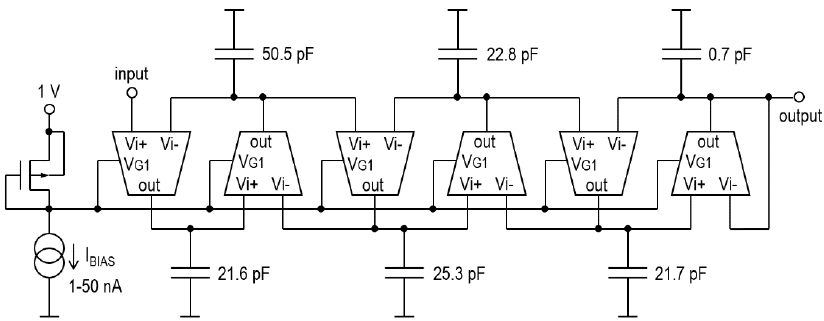
Figure 11. The 6th-order low-pass G m -C (transconductor-C) filter with Chebyshev approximation.